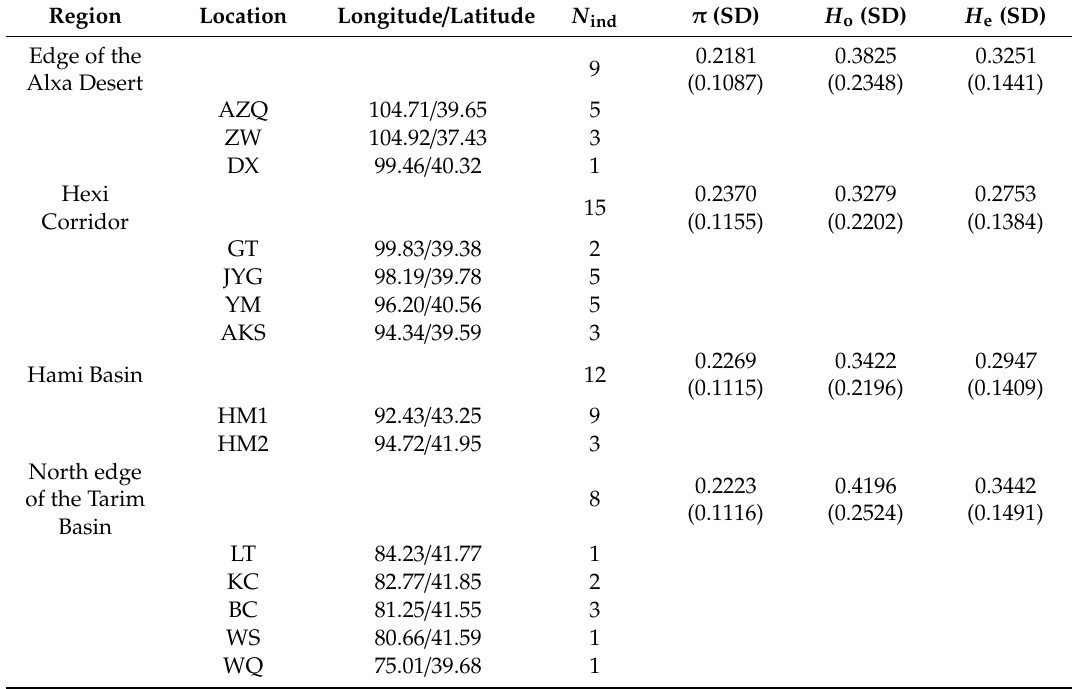
Table 1. Population information and genetic diversity of Gymnocarpos